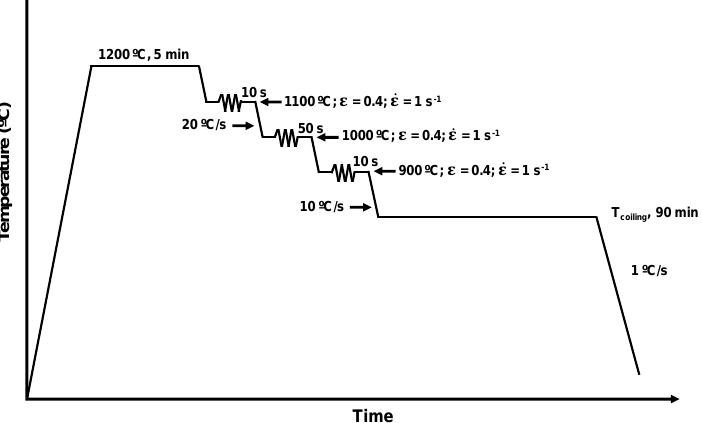
Figure 1. Schematic of the thermomechanical schedule.